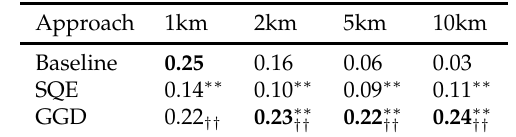
Table 4: MAP (reported to two decimal places) of GIR approaches. Symbol ** denotes a significant difference ( p < 0 . 001 , Students T-test) compared with Baseline. Similarly symbol †† denotes a significant difference with